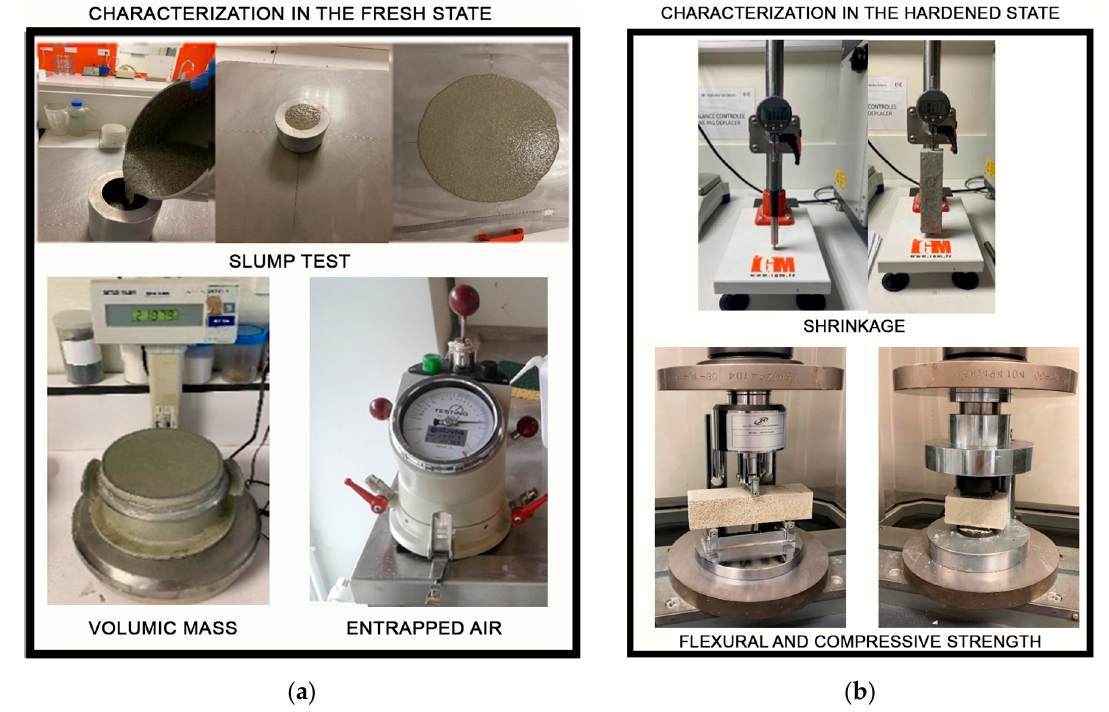
Figure 4. ( a ) Characterization in the fresh state. Tests carried out: slump test, volumic mass, and entrapped air. ( b ) Characterization in the hardened state. Tests carried out: shrinkage, flexural, and compressive strength.